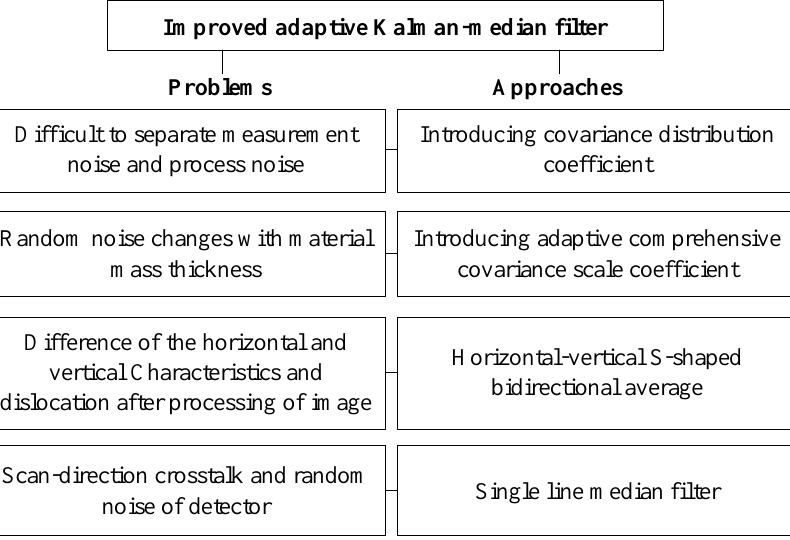
Figure 2. The sketch map of DE-XRT image filtering.